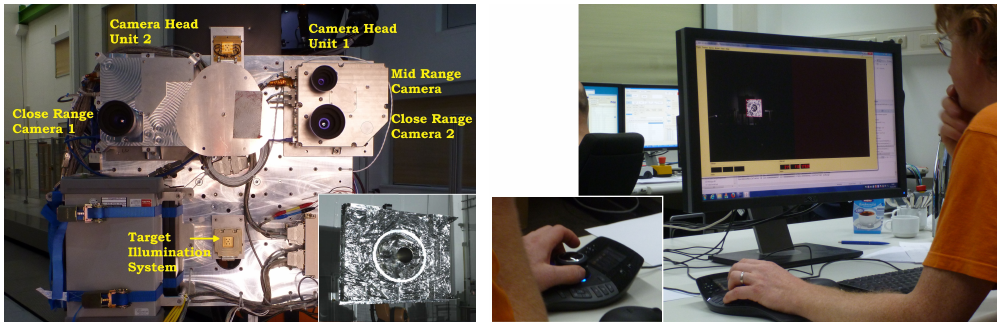
Figure 20: VIBANASS sensor system (left) and operator-in-the-loop (right).